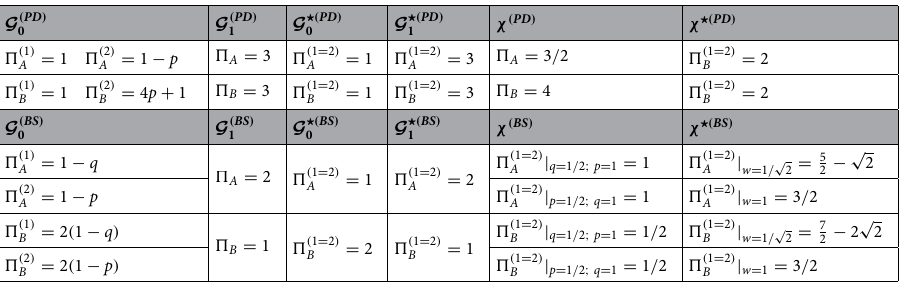
Table 2. Pay-offs when the information is minimal and maximum for Prisoner’s Dilemma and Battle of the